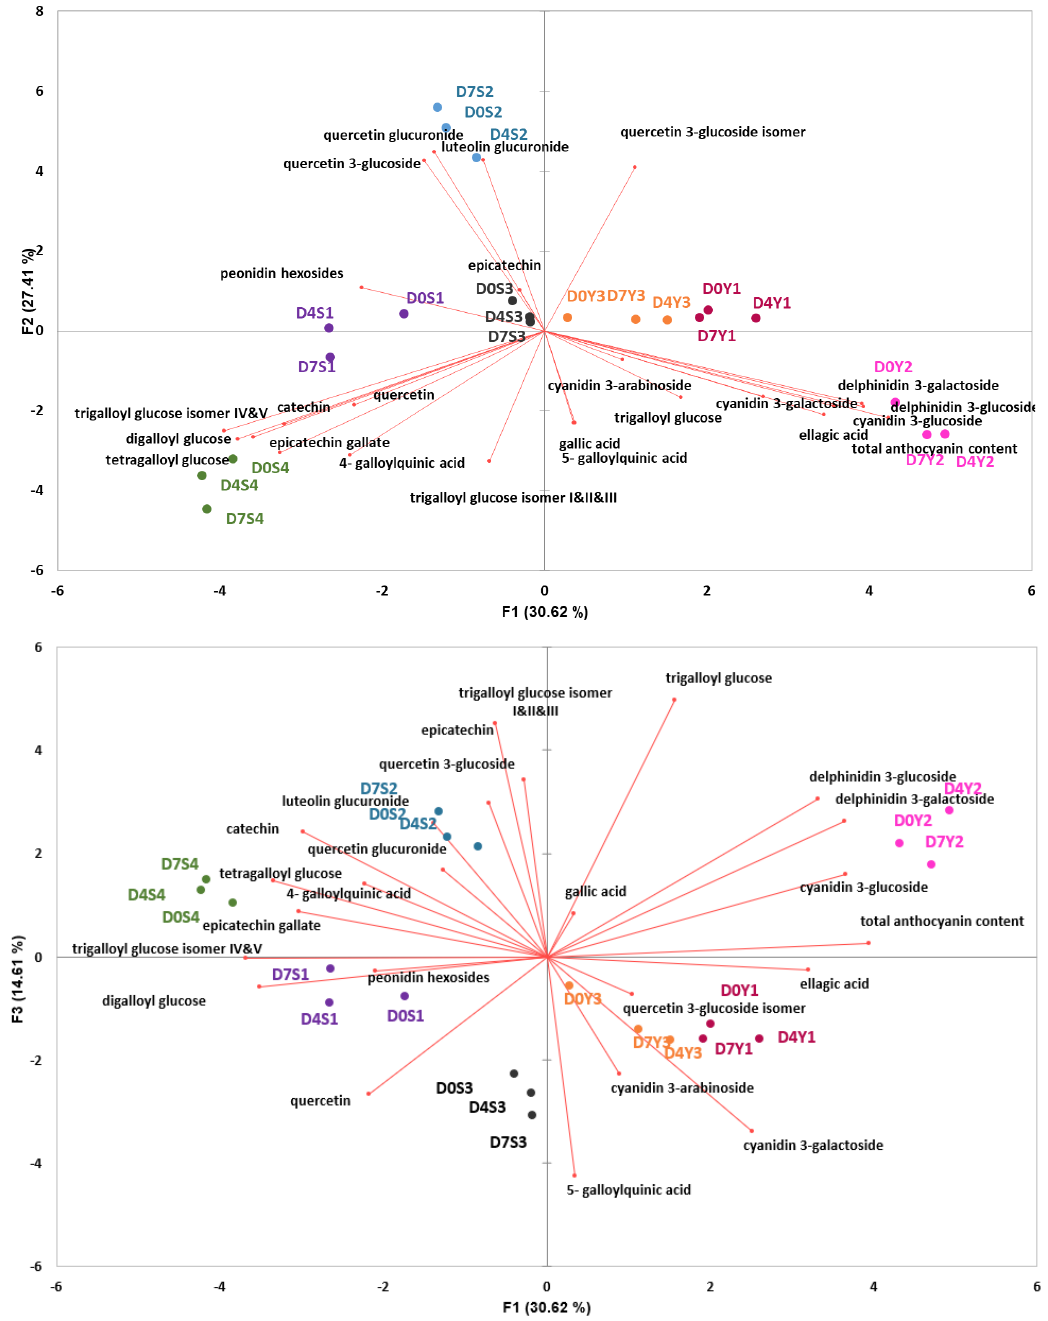
Figure 2. PCA bi − plots of phenolic compounds in Burdekin plums harvested from seven trees (S1, S2, S3, S4, Y1, Y2, Y3) on three storage days (D0, D4, D7).